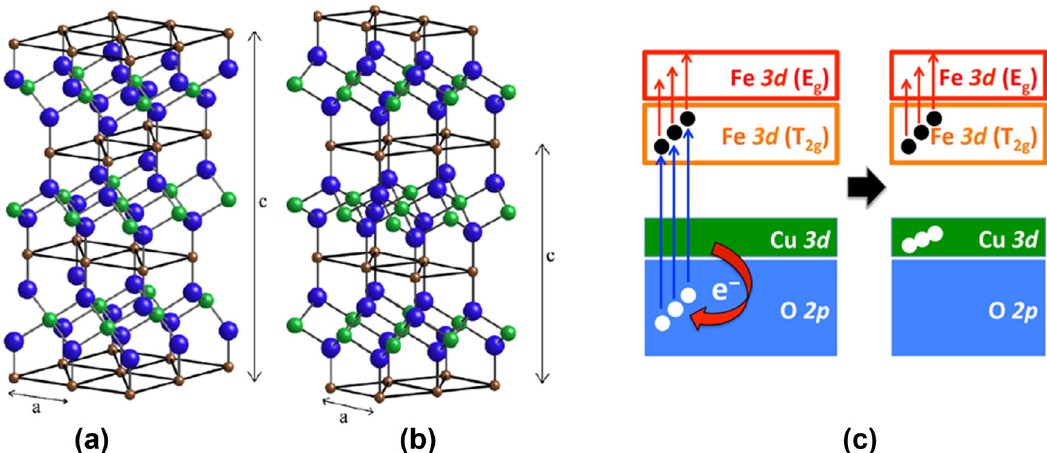
Figure 3: Two polytypes of the delafossite structure: ( a ) 3R and ( b ) 2H ( brown spheres – Cu, green – M, and blue – O ) . ( Reprinted with permission from ref. [ 119 ] . Copyright © 2006, Elsevier ) . ( c ) Upon optical excitation of CuFeO 2 , electrons are promoted from hybridized Cu 3d and O 2p states in the valence band to Fe 3d states in the conduction band. This is followed by an ultrafast hole thermalization where electrons in the higher lying Cu 3d states back fi ll the photogenerated holes in the lower O 2p states. ( Reprinted with permission from ref. [ 129 ] . Copyright © 2018, American Chemical Society )